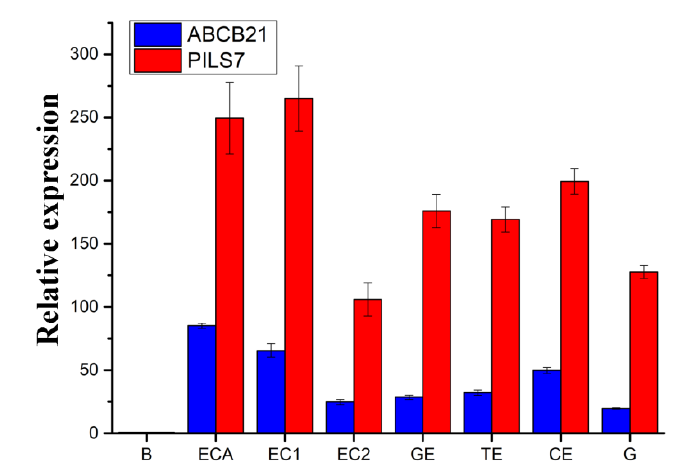
Figure 8. The expression levels of ABCB21 and PILS7 at different stages of somatic embryos. B, scales; ECA, embryonic cells appear; EC1, early proembryo; EC2, late proembryo; GE, globular embryo; TE, torpedo embryo; CE, cotyledon embryo; G, germination.